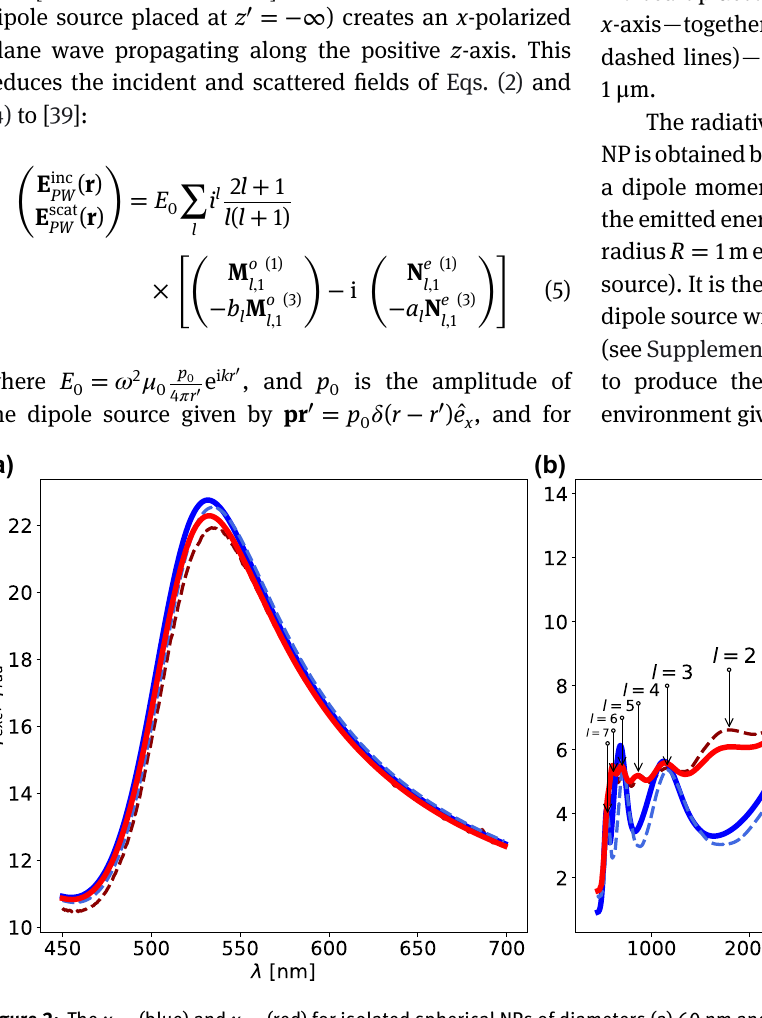
(blue) and 𝛾 (red) for isolated spherical NPs of diameters (a) 60 nm and (b) 1 μ m. The analytical multipolar Figure 2: The 𝛾 exc rad decompositions (full lines) and numerical calculations (dashed lines) are plotted together for comparison. In (b), the series of resonances are labelled by their corresponding angular momentum quantum number, l , which emerges from the multipolar